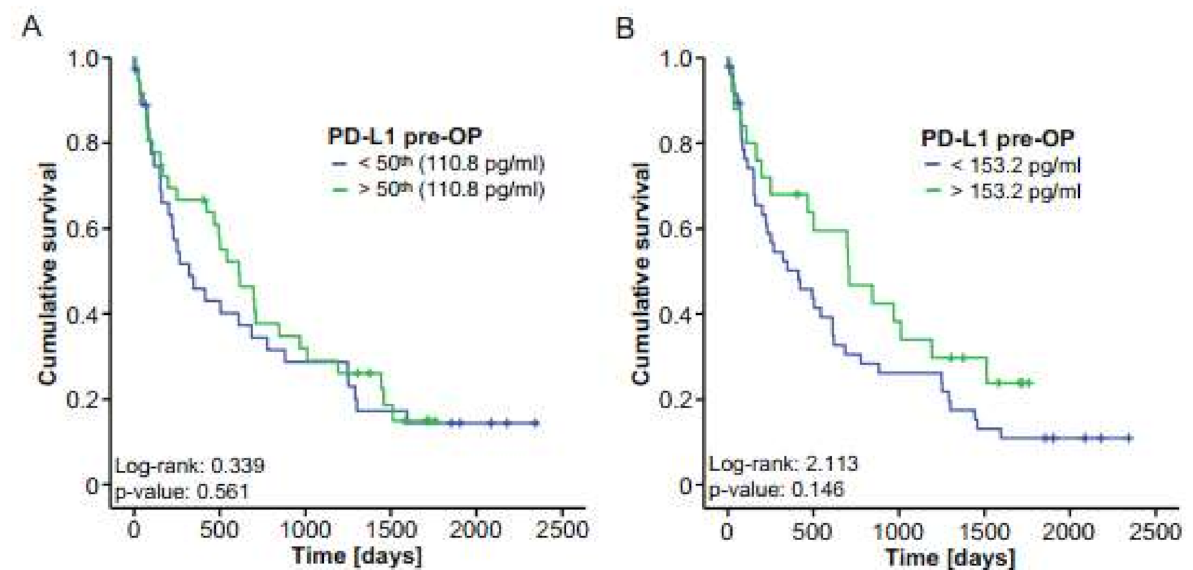
Figure 3. Initial serum PD-L1 does not reflect the outcome of BTC patients after tumor resection. ( A ) Kaplan–Meier curve analysis using the 50th percentile as a cut-off reveals no survival benefit for patients with high or low PD-L1 levels. ( B ) BTC patients with PD-L1 serum levels below the ideal prognostic cut-off value of 153.2 pg/mL show a nonsignificant trend towards an impaired survival. ** p <